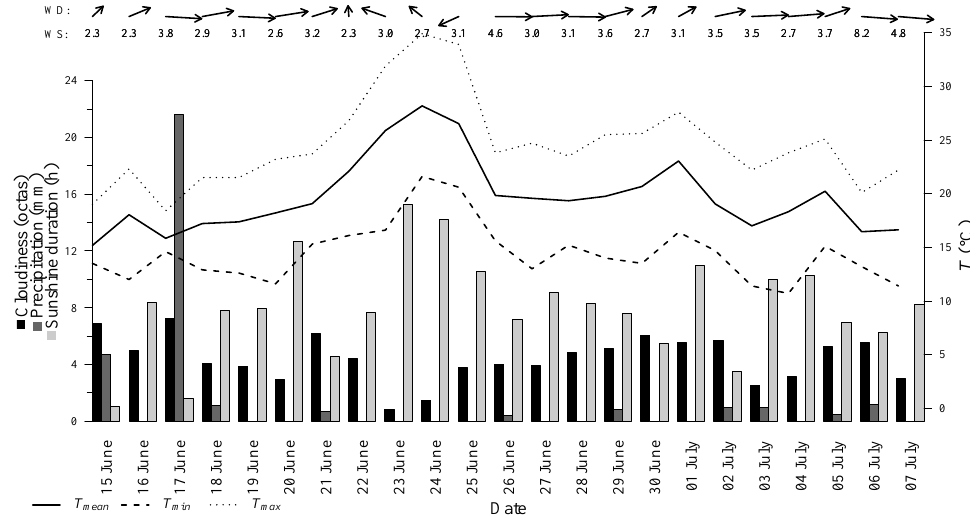
Figure 2. Weather conditions during the measurement campaign in summer 2016 at Berlin-Tempelhof, (TEMP) (German Weather Service, DWD). Cloudiness data are from TEGL (Berlin-Tegel). WD: wind direction, WS: wind speed, T : air temperature, T mean : daily mean T , T min : daily minimum T , T max : daily maximum T